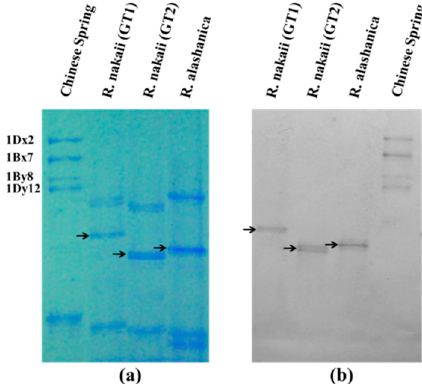
Figure 1. Sodium dodecyl sulfate-polyacrylamide gel electrophoresis (SDS-PAGE) ( a ) and Western blotting ( b ) patterns of the high-molecular-weight glutenin subunits (HMW-GSs) from R. nakaii and R. alashanica . The HMW-GSs in Roegneria species are indicated by arrows. The HMW-GSs (1Dx2, 1Bx7, 1By8, and 1Dy12) of common wheat variety Chinese Spring were used as